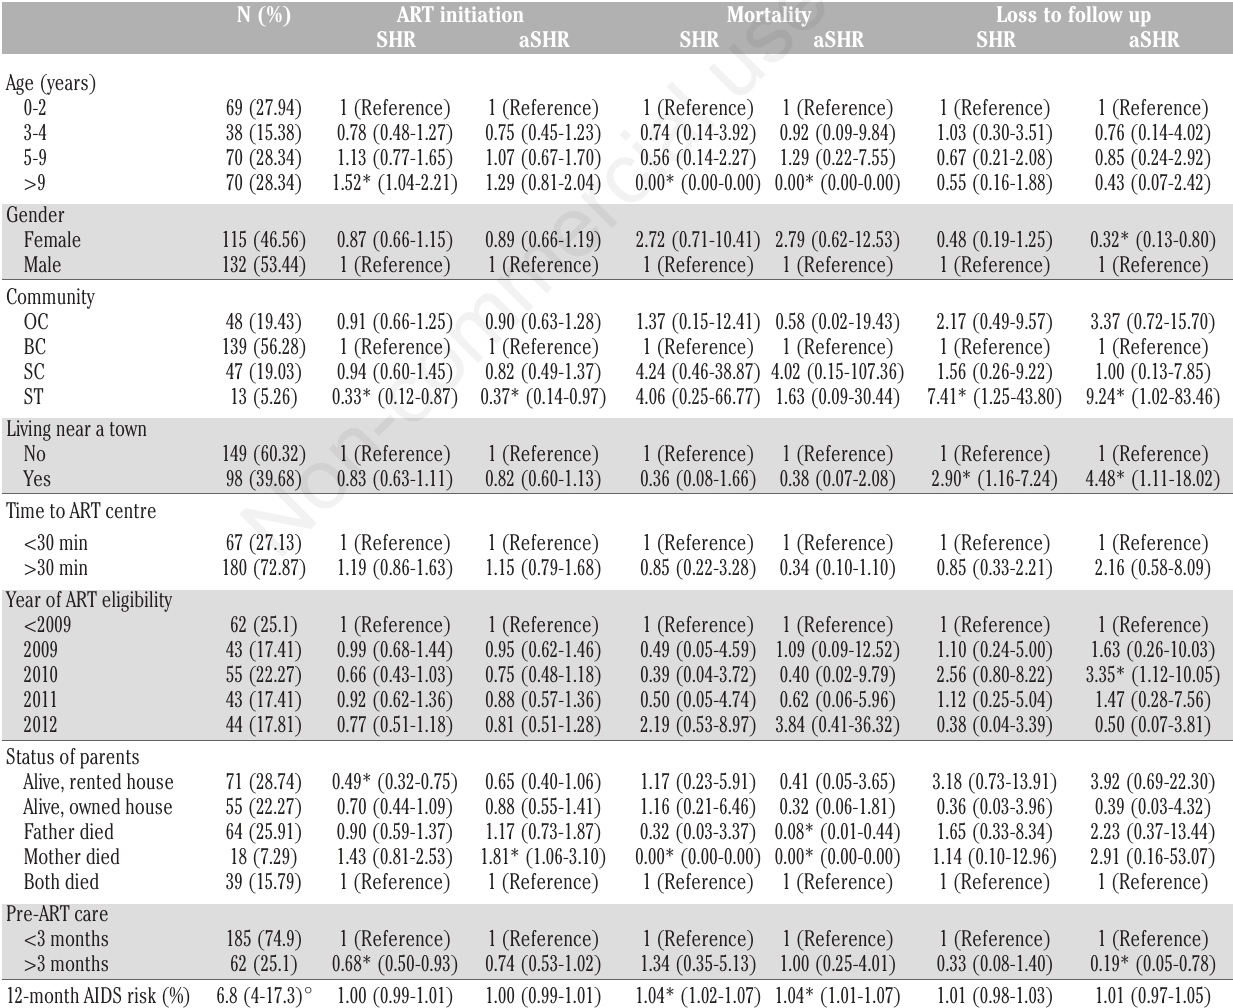
Table 1. Baseline characteristics and raw and multivariable analysis of factors associated with antiretroviral therapy (ART) initiation, mortality and loss to follow up of 247 children eligible for ART in Anantapur, India. N